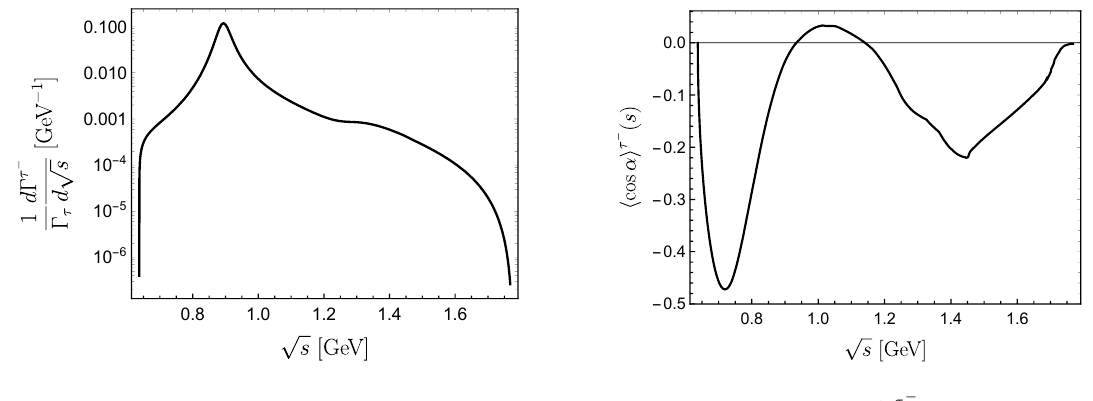
(cid:0) normalized by d p s